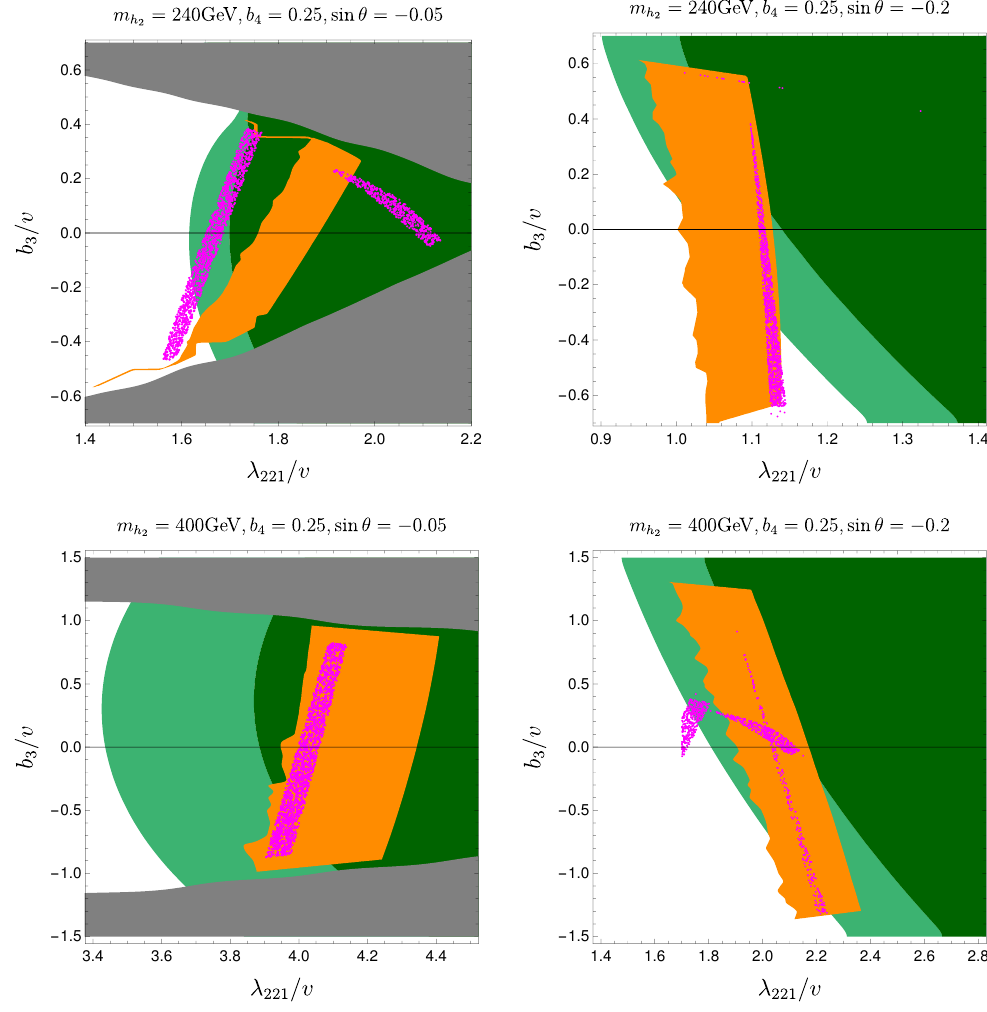
Figure 1 . Comparison with the results from the non-perturbative study in ref. [10]. Here b 3 is in the tadpole basis where a shifting of the s (cid:12)eld leads to v s = 0 and the appearance of a tadpole term in eq. 2.1. The convertion between these two sets of parameters can be found in the appendix i(cid:21) 221 h 2 h 1 = 2. Aside from b 3 , all the other parameters of [14]. (cid:21) 221 is the coupling of h 2 h 2 h 1 : V 2 2 shown here are basis invariant. The minus sign of (cid:18) is due to a di(cid:11)erent de(cid:12)nition of the mixing angle from [10] (compare eq. 2.2 with eq.A2-A3 in [10]). These (cid:12)gures correspond to the four plots in (cid:12)gure 5 of [10], where the light-green region gives a (cid:12)rst order phase transition from their non- perturbative study, the dark-green region indicates where higher dimensional operators is needed in the e(cid:11)ective theory framework, the yellow one gives the corresponding region from a full one-loop perturbative analysis, and the gray region is excluded by vacuum stability requirement. All these regions are taken from ref. [10]. Overlaid magenta points on these (cid:12)gures are from our study where a gauge-independent high temperature expansion is adopted when calculating the (cid:12)nite temperature e(cid:11)ective potential.